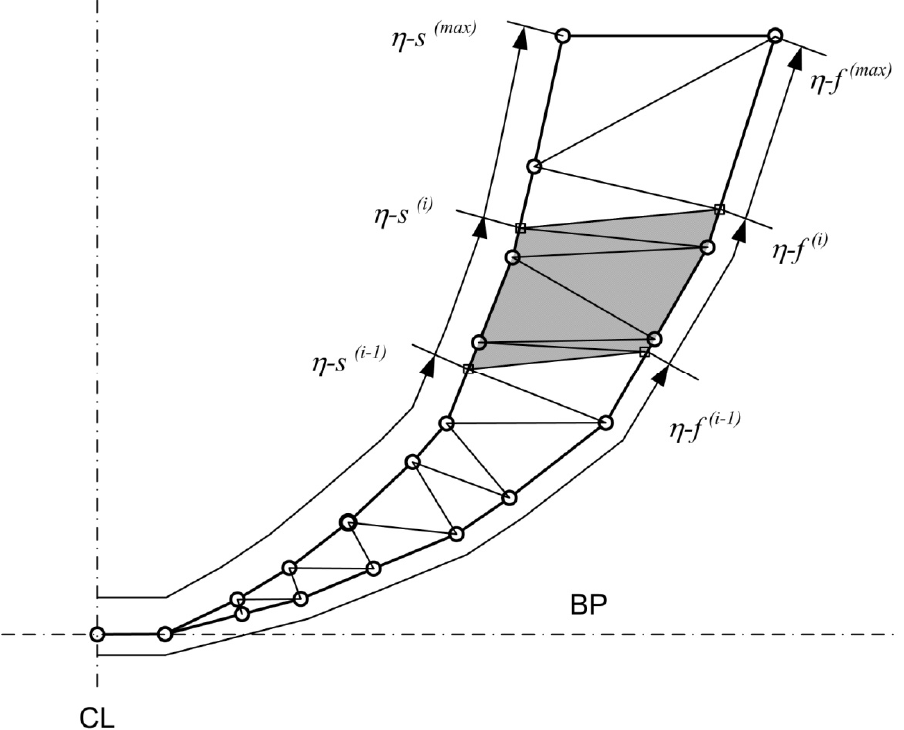
Figure 4. Wireframe triangulation of ship surfaces.